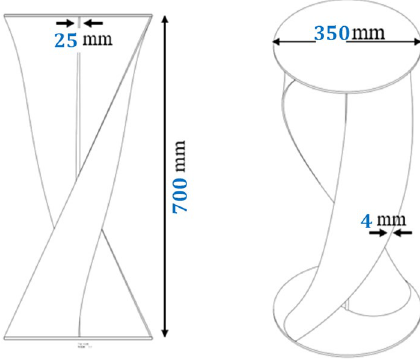
Fig. 1 Schematic of Savonius helical wind